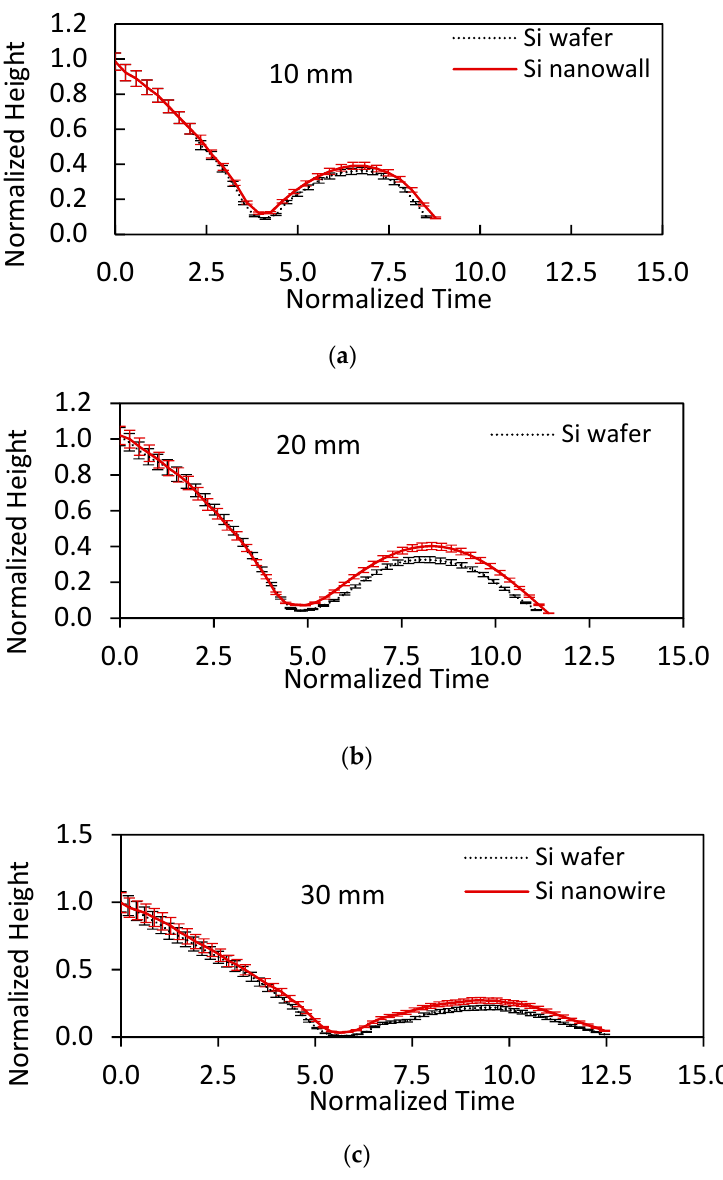
Figure 9. Rebound heights with normalized time for 20 μ L volume droplet impacting on hydrophobized as ‐ received silicon and hydrophobized etched silicon wafers from initial heights of ( a ) 10 mm, ( b ) 20 mm, and ( c ) 30 mm.